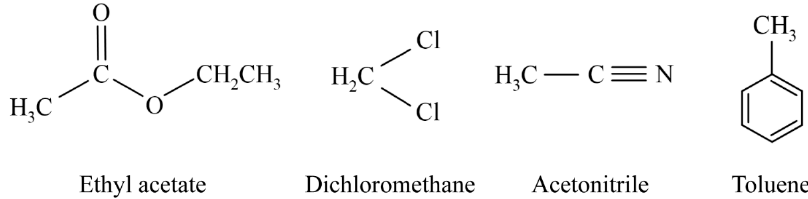
Figure 6. Anhydrous solvents used for the ECL measurements with PeNCs.